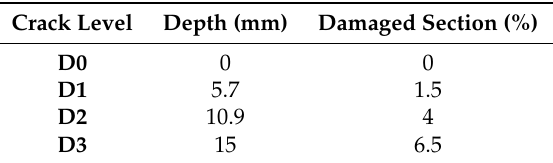
Table 3. Crack levels and depths.